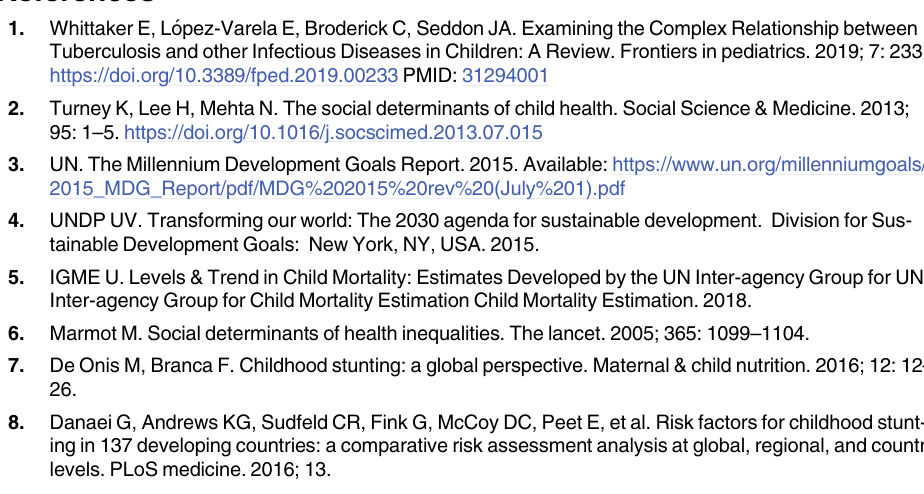
S1 Fig. Scree plot of eigenvalues after factor analysis. S2 Fig. Confirmatory factor analysis model for women’s empowerment (EDHS-2016). S1 Table. Result of EFA. S2 Table. The difference in distribution of the five dimensions of women’s empowerment by the four child health